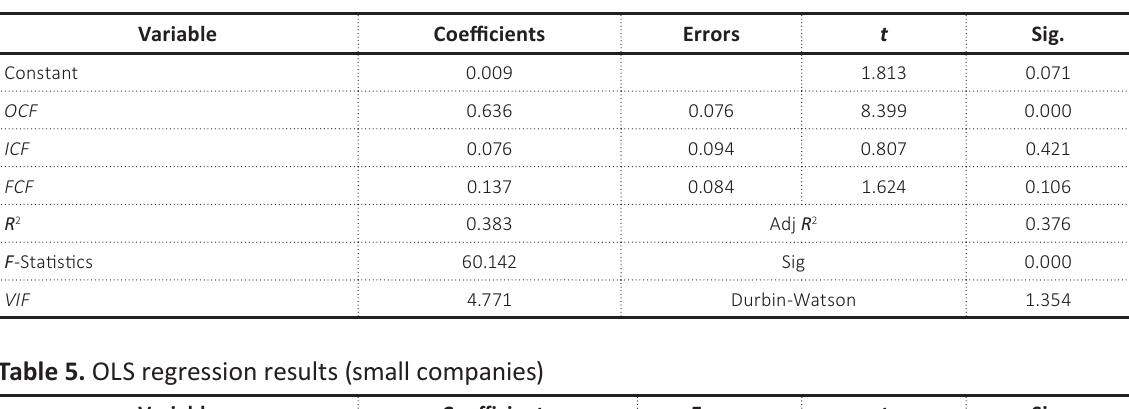
Table 4. OLS regression results (large companies)